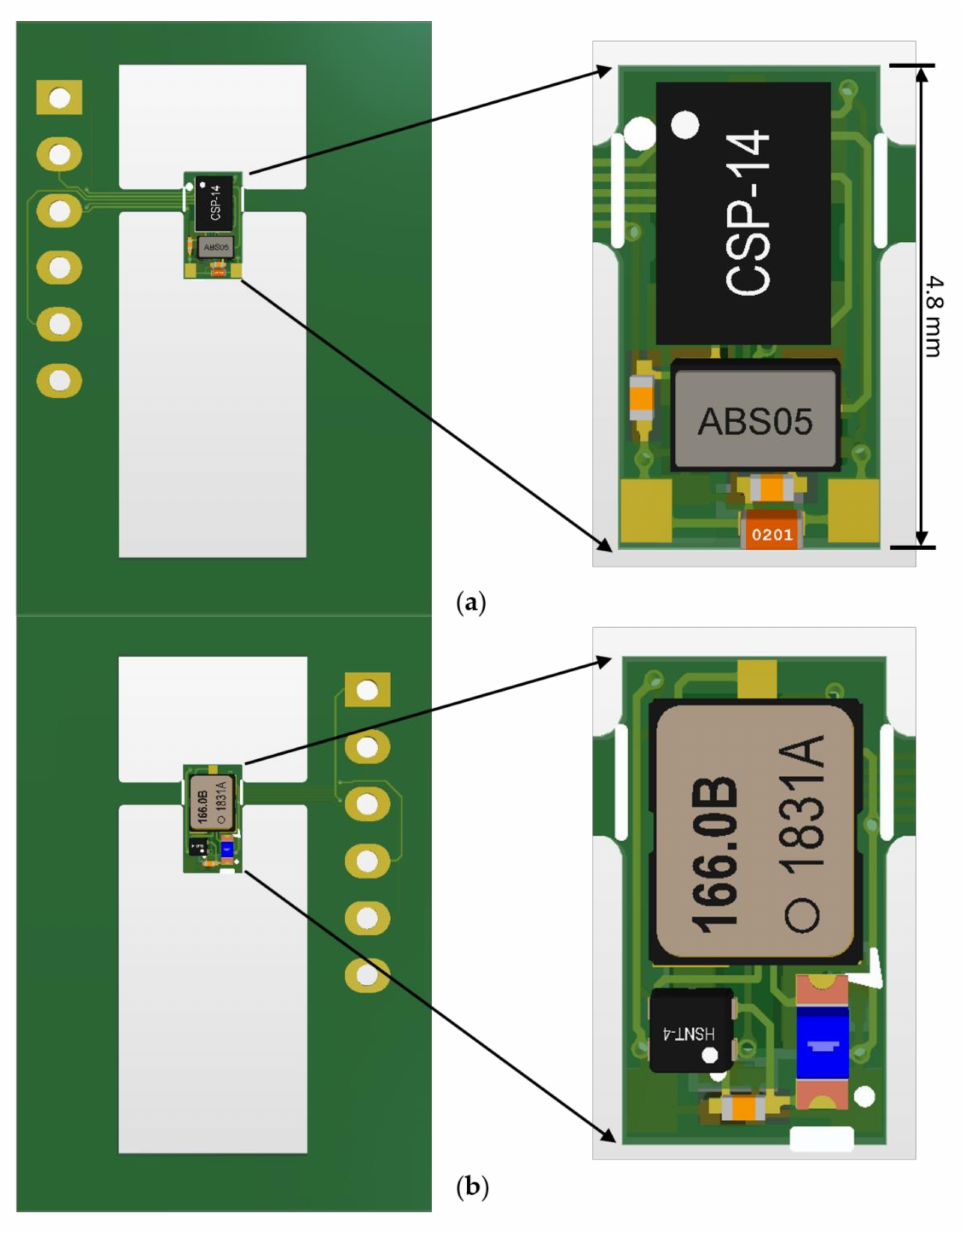
Figure 2. Circuit layout for the option 2 transmitter: ( a ) front side; ( b ) back